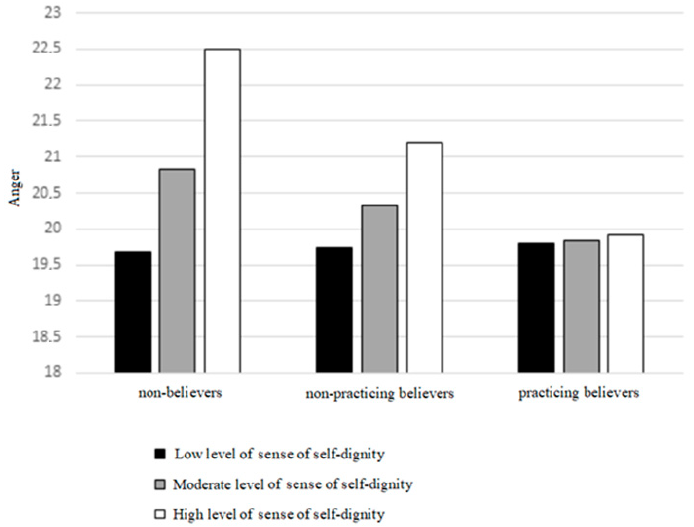
Figure 4. Simple slopes plot for the moderating role of religiosity in the relationship between sense of self-dignity and anger.